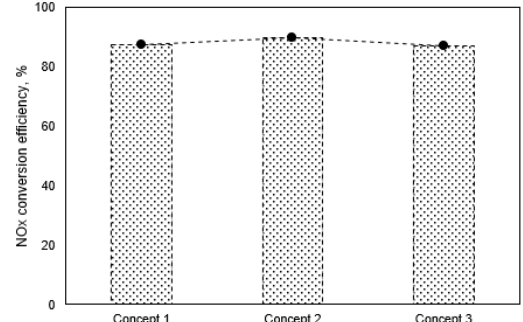
Figure 4. NOx conversion efficiency results during NRTC with different SCR size.